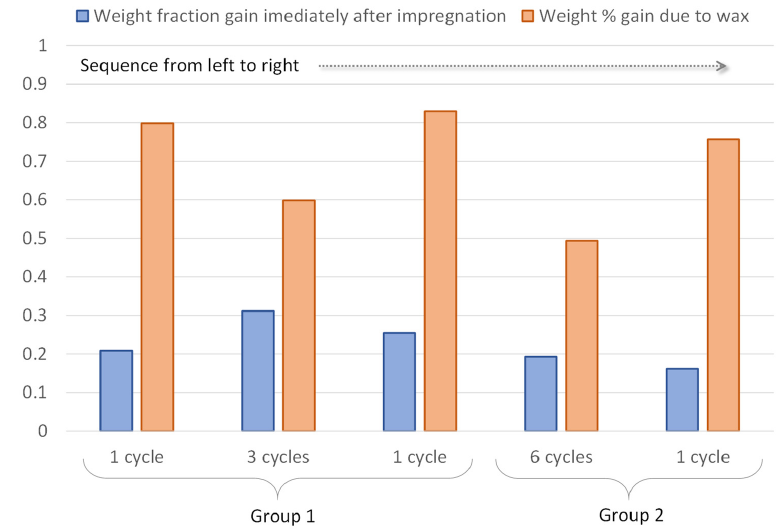
Figure 8. Weight gain measured after successive extraction/impregnation cycles. Weight gain is shown as fraction immediately after impregnation and % after oven-drying.